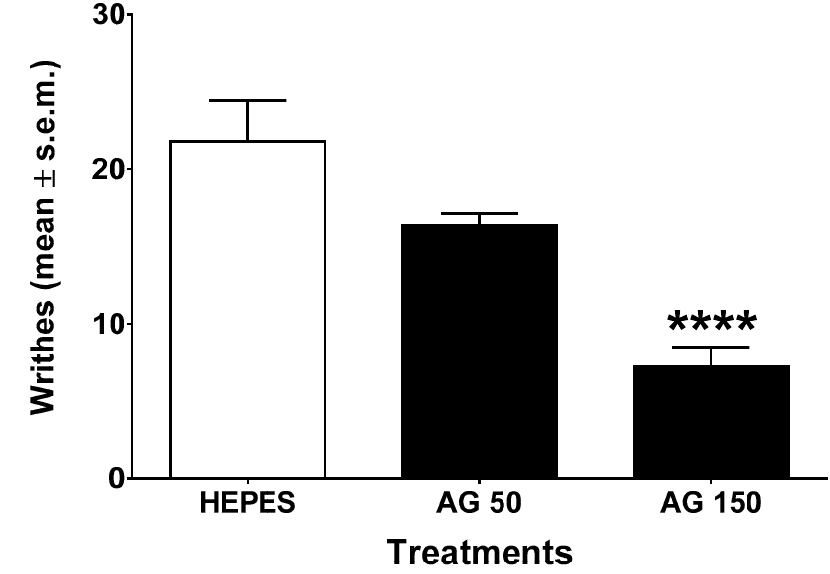
Figure 2. Writhing test. Effects induced by vehicle (Hepes, 10 mL/kg, intraperitoneally (i.p.)) and ammonium glycyrrhizate (AG, 50 or 150 mg/kg, i.p.) administered 24 h before acetic acid (0.6% v/v in salina, 10 mL/kg, i.p.). **** denotes p < 0.0001 vs. Vehicle. n = 9.